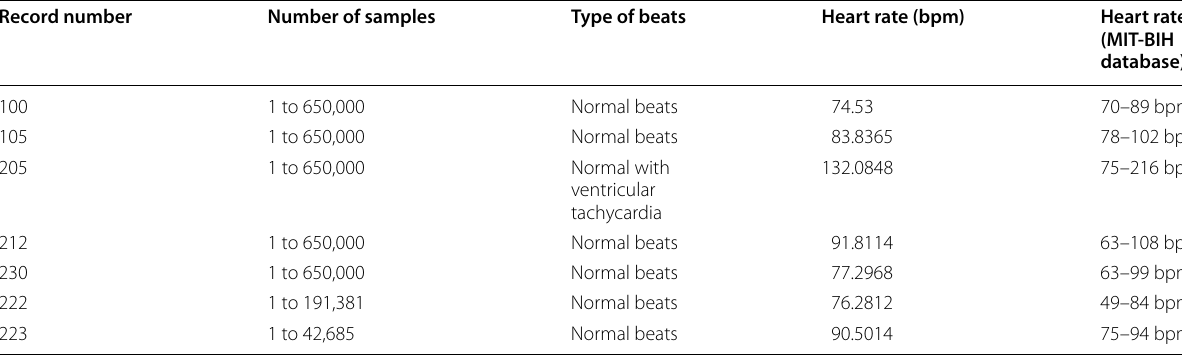
Table 2 Heart rates from the proposed method compared with standard MIT-BIH records of normal